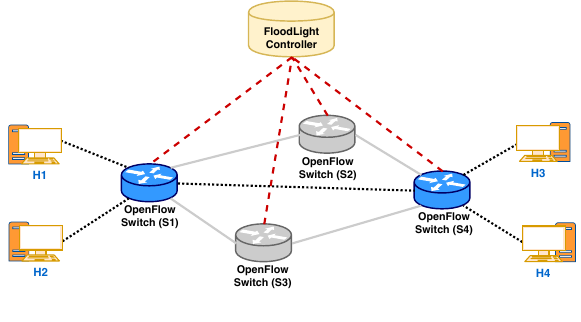
Figure 2. Floodlight